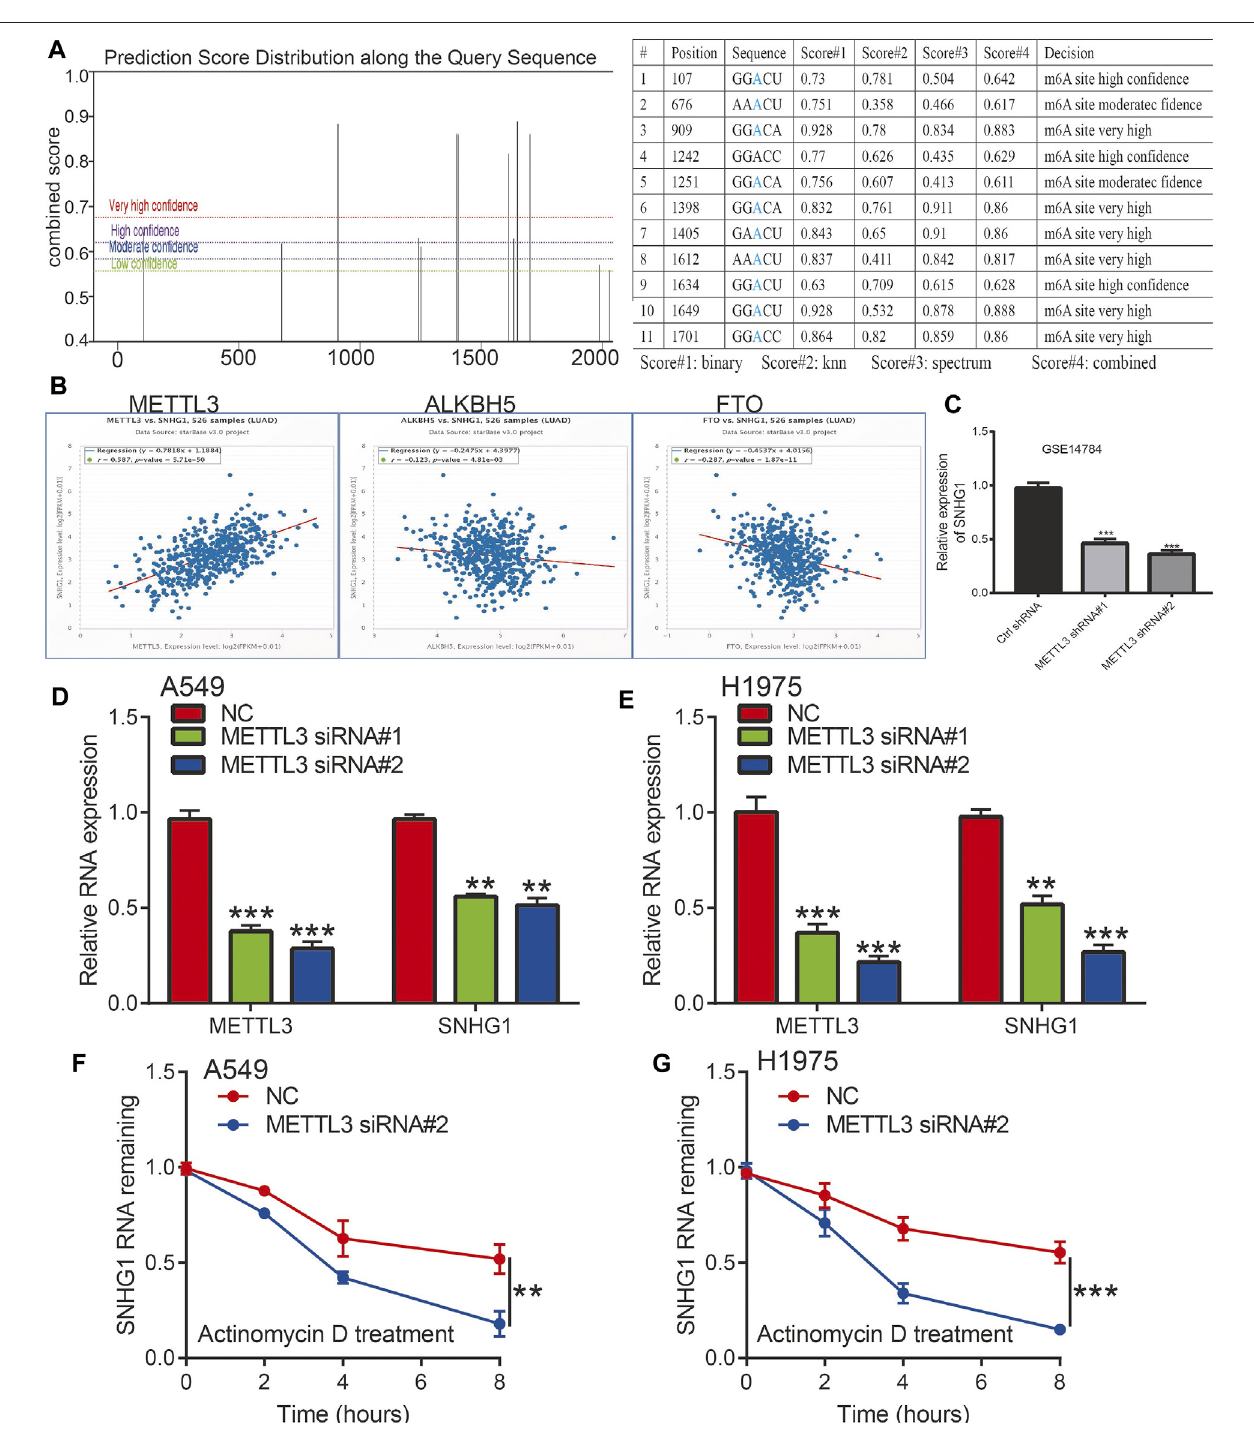
FIGURE 10 | The m6A modi fi cation is enriched in SNHG1 and improves its transcript stability. (A) The RNA m6A methylation site distribution. (B) The correlation between SNHG1 and METTL3, ALKBH5, and FTO in TCGA LUAD. (C) The expression of SNHG1 after depletion of METTL3 analysis by the GEO database. (D,E) The expression of SNHG1 after depletion of METTL3 in NSCLC cell lines examined by qRT-PCR assay. (F,G) METTL3 knockdown in A549 and H1975 cells signi fi cantly downregulated SNHG1 RNA abundance. * p < 0.05, ** p < 0.01, *** p < 0.001.